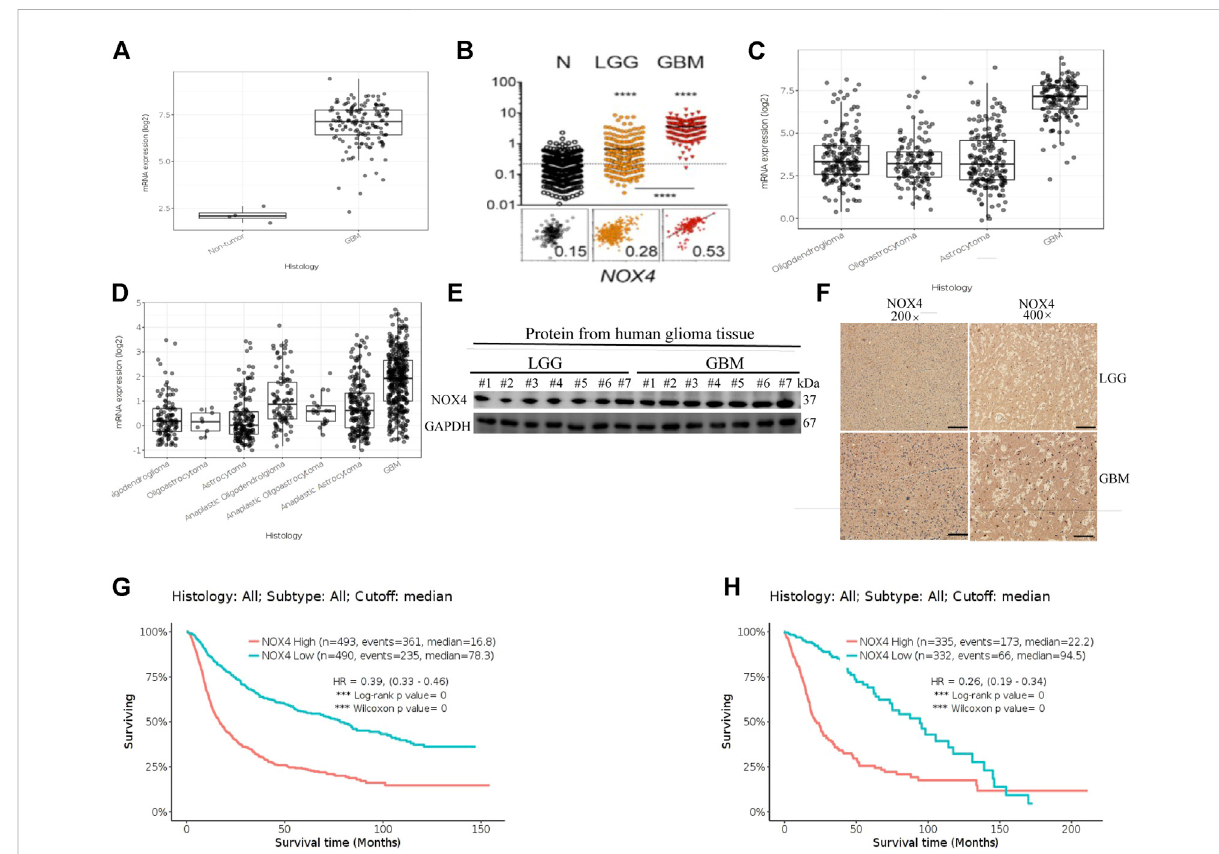
FIGURE 1 NOX4 is upregulated and associates with prognosis in glioma. (A,B) NOX4 mRNA expression in non-tumor tissue, low grade glioma (LGG) and high grade glioma (HGG) in TCGA datasets; (C,D) NOX4 mRNA expression in different histology in TCGA datasets and CGGA datasets; (E) Western blotwasperformedtocomparedFTLexpressioninLGGandGBM,LGG,n=7;GBM,n=7,GAPDHusedasloadingcontrol; (F) Representativeimages of IHC staining of NOX4 in glioma tissues; (G,H) Kaplan-Meier survival analysis for NOX4 expression in all glioma patients in TCGA datasets and CGGAdatasets.ThemedianvalueofNOX4levelswassetasthecut-offlevel.HR,hazardration;CI,con fi denceinterval.*** p < 0.001,ascomparedto